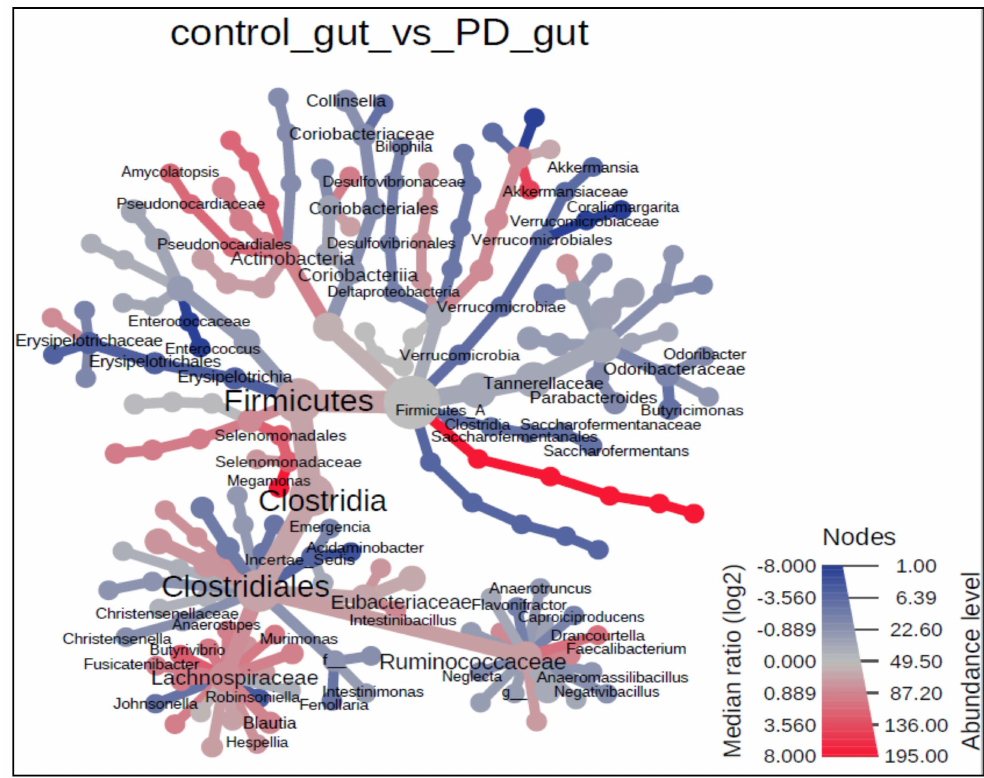
Figure 8. The heat tree analysis, showing the taxonomic differences of fecal microbiota between PD and healthy controls. Only significant taxon names were labeled on the heat tree. Statistical significance was calculated using the non-parametric Wilcoxon Rank Sum test with 0.05 Wilcoxon p -value